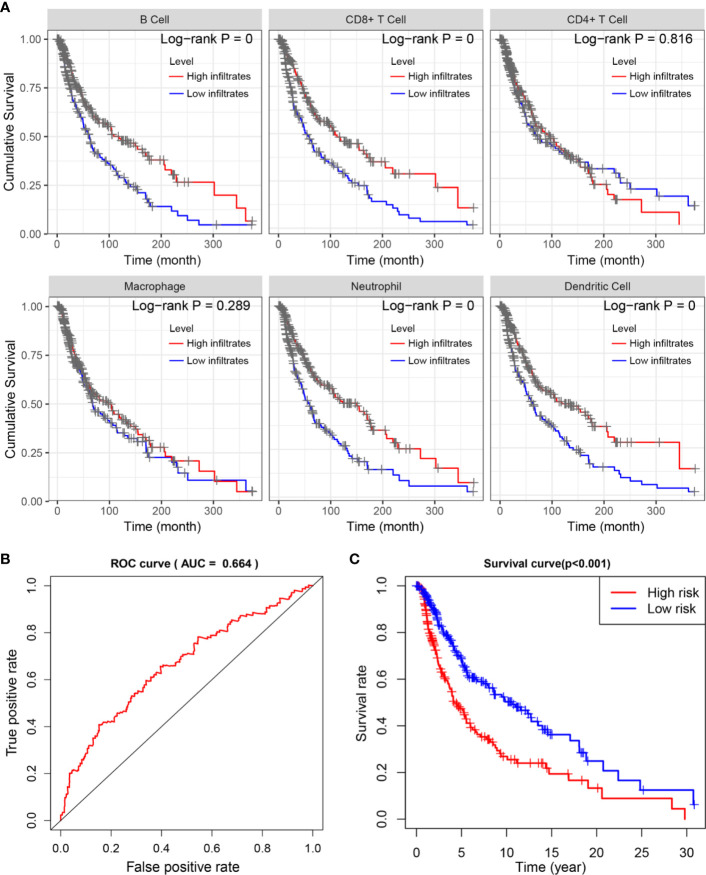
Survival analysis of differentially immune cells across two TMB groups. (A) Kaplan-Meier analysis revealed that lower infiltration levels of B cell, CD8+ T cell, neutrophil, and dendritic cell correlated with poor survival outcomes in SKCM. (B, C) Construction and assessment of TMBPI for SKCM (AUC of 3-year OS prediction = 0.664), where patients with higher TMBPI conferred poor survival outcomes (P < 0.001). TMB, tumor mutation burden; SKCM, skin cutaneous melanoma; TMBPI, Tumor Mutation Burden Prognostic Index; AUC, Area Under Curve; ROC, Receiver Operating Characteristic; OS, overall survival.